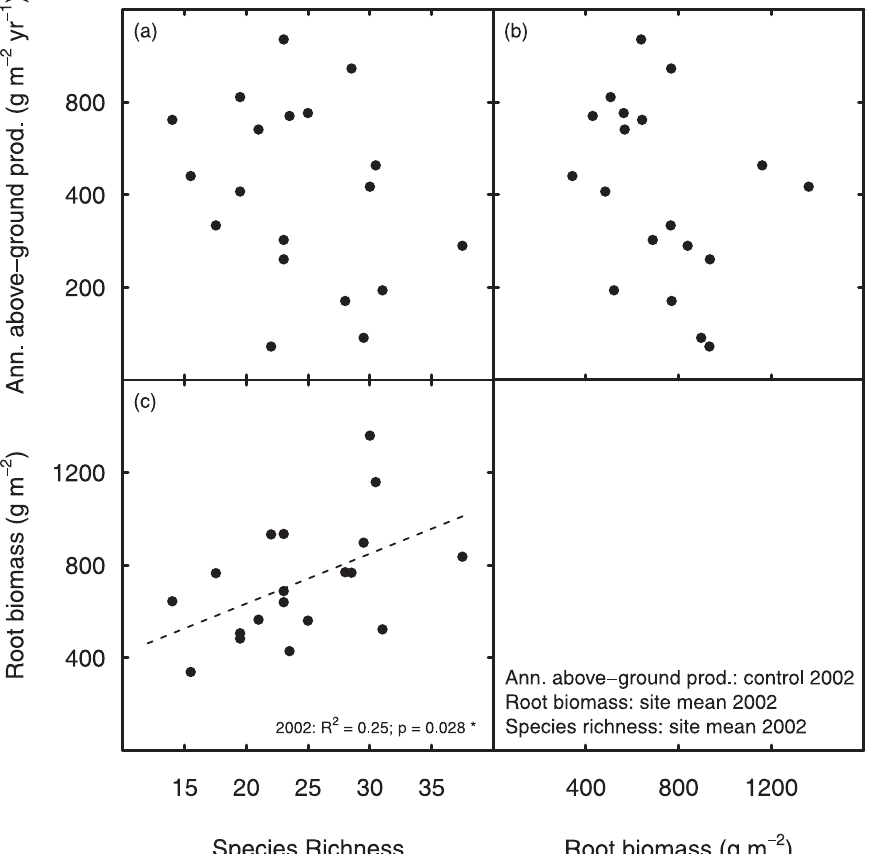
Fig 3. Correlations between biotic drivers. Scatterplot matrix for correlations between annual above-ground productivity (under control conditions), species richness and standing root biomass in 2002. Since neither species richness nor standing root biomass showed significant changes in response to the drought treatment, site means from control and drought plots are shown.